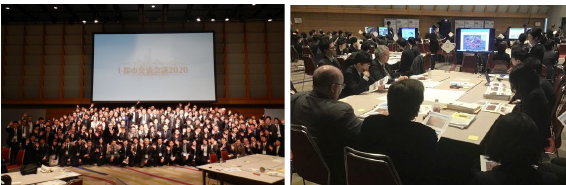
Figure 13. i-Urban Exchange Meeting Conference